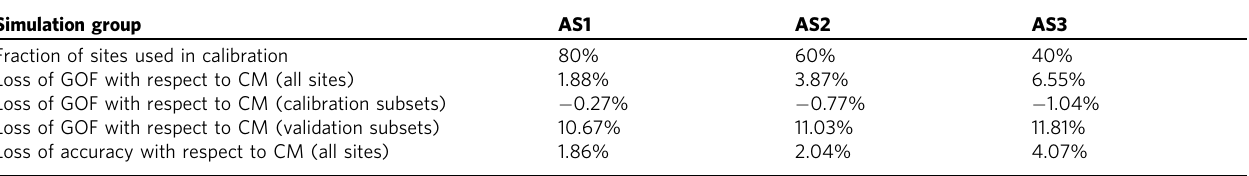
Table 1 Performance of additional simulation